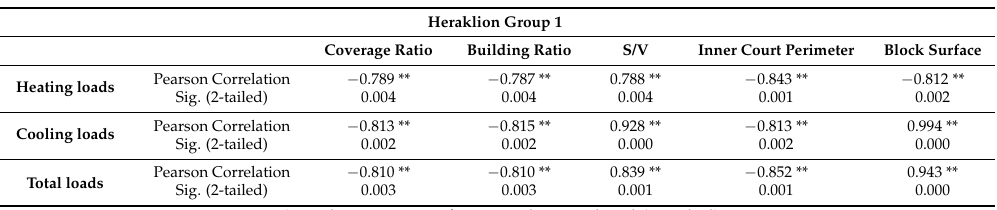
Table 9. Correlation of the form parameters to the load demand of the urban blocks of group 1 for the climate of Heraklion.